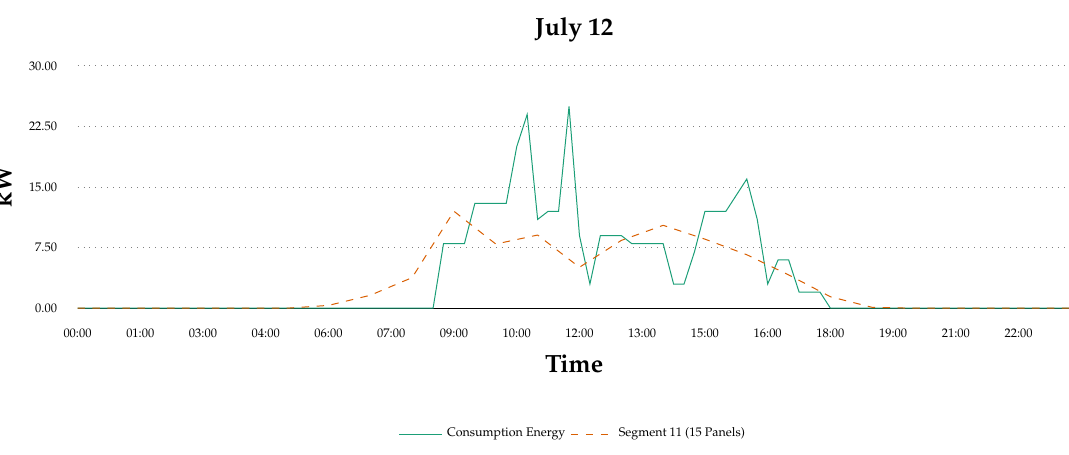
Figure 14. 12 July scenario: consumption energy data with simulated generation energy at 15 min